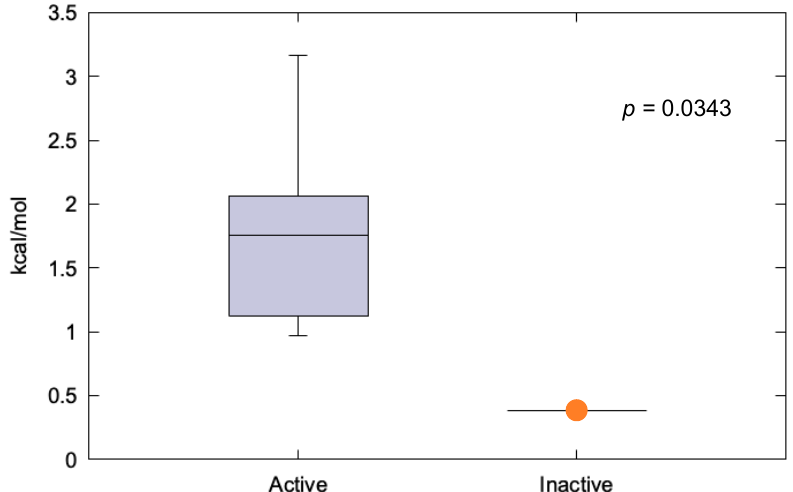
Scheme 1. Distribution of calculated folding free energy di ff erences, in kcal / mol, upon the Gly48Leu mutation, for the active and inactive conformations of G α q, G α i / q. The center line of the box represents the median. The whiskers extent from the ends of the box to the most distant point whose lies within